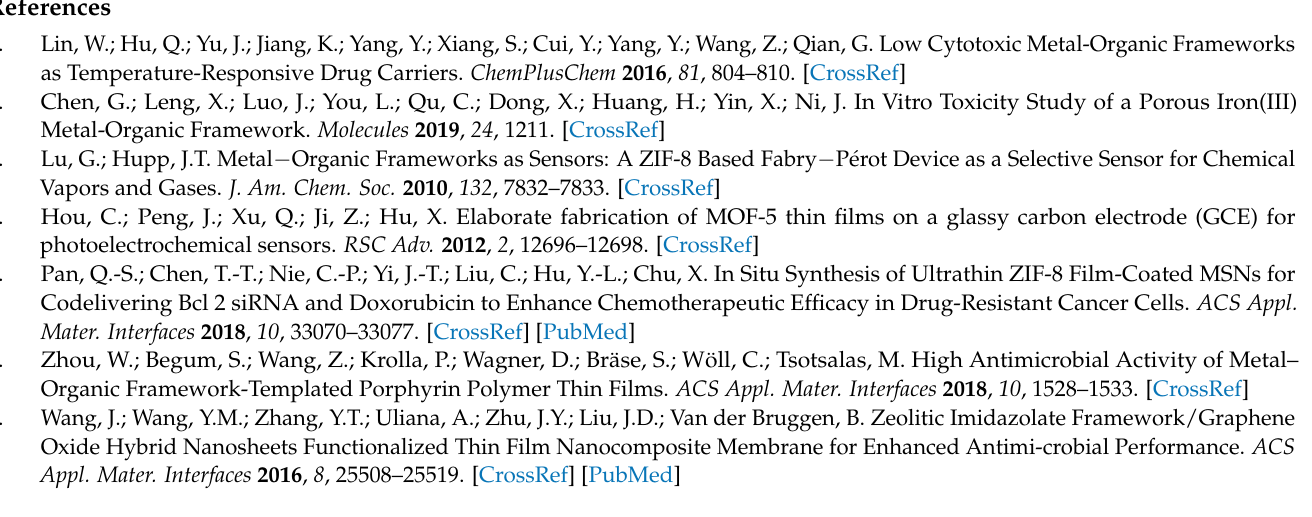
different laser fluences, Figure S2: Histogram size analysis of MAPLE deposited samples at different laser fluencies, Figure S3: Cross sections of thin films; Figure S4: C1s, O1s, and N1s high-resolution Figure S5: Zn2p high-resolution XPS spectra of ZIF-8 controls and MAPLE deposited ZIF-8 thin films, Table S1: Element average weight percent of MAPLE films obtained at different fluencies, Table S2: Atomic ratios for ZIF-8 control and MAPLE deposited ZIF-8 films. The Zn doublet Zn 2p3/2 and Zn 2p1/2 can be identified at 1022.8 eV and 1046 eV, with the characteristic split spin-orbit components (23.2